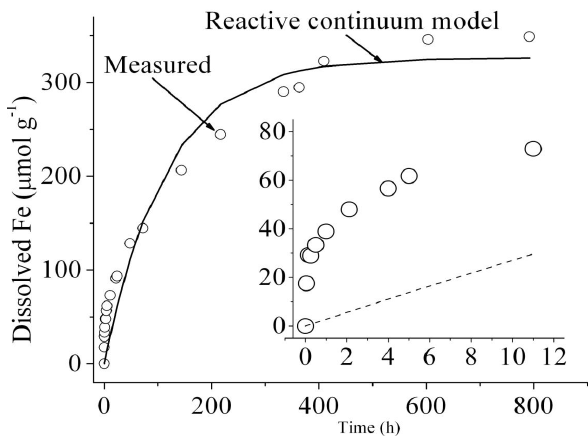
Fig. 4. Fitting of the Fe dissolution curve of Tibesti-PM 2 . 5 at pH 1 and a dust/liquid ratio of 60mgL − 1 using the reactive continuum model. The inset shows the measured Fe compared with the pre- dicted values over the first 12h of the experiments in more detail. k values of 25, 0.5, and 0.005 h − 1 and M 0 of 25, 30,